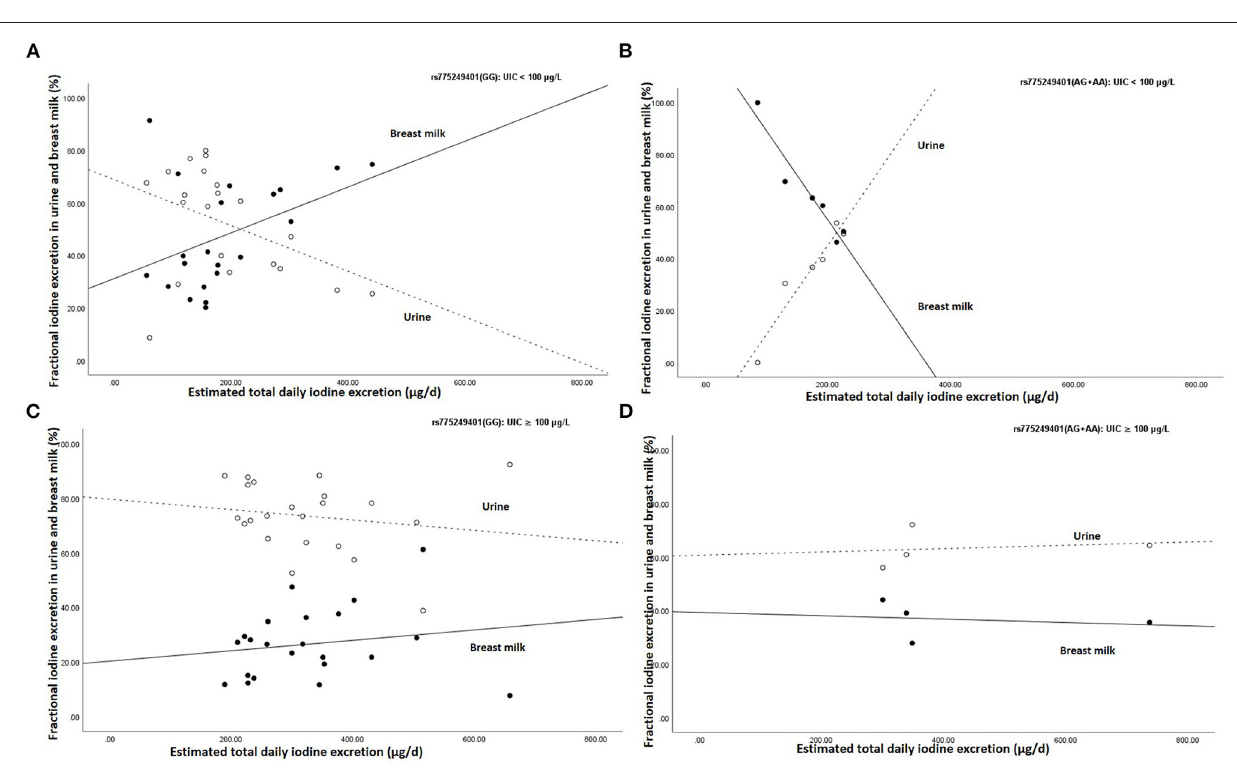
FIGURE 2 | Association between estimated daily iodine and fractional iodine excretion in breast milk and urine (A) the homozygous G group (rs775249401 (GG) ) with UIC < 100 µ g/L ( n = 21), (B) the (A) allele carriers for the rs775249401 (AG + AA) with UIC < 100 µ g/L ( n = 6), (C) the homozygous G group (rs775249401 (GG) ) with UIC ≥ 100 µ g/L ( n = 22) and (D) the (A) allele carriers for the rs775249401 (AG + AA) with UIC ≥ 100 µ g/L ( n = 4). The open data points represent fractional excretion of iodine in urine and the filled data points, the fractional excretion in breast milk. The dotted line is the regression line for fractional excretion of iodine in urine. The solid line is the regression line for fractional excretion of iodine in breast